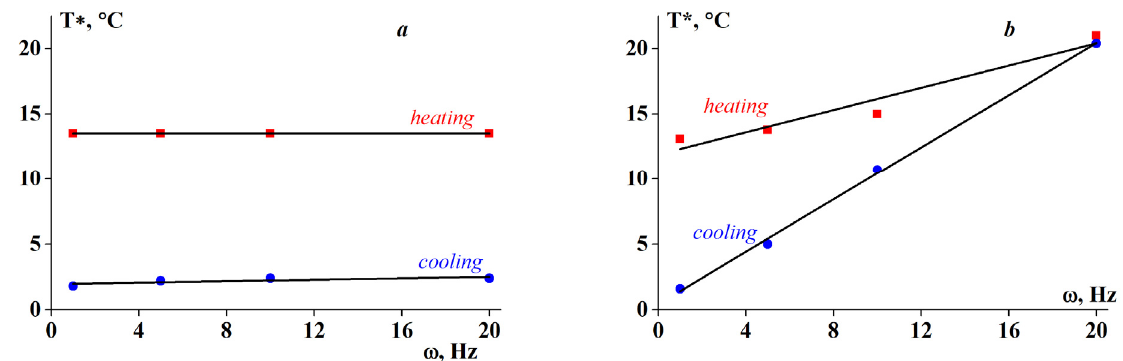
Figure 4. Transition temperature T* dependency on frequency for alginate-gelatin complexes with SA-gelatin mass ratios Z of ( a ) 0.02 and ( b ) 0.2 for heating and